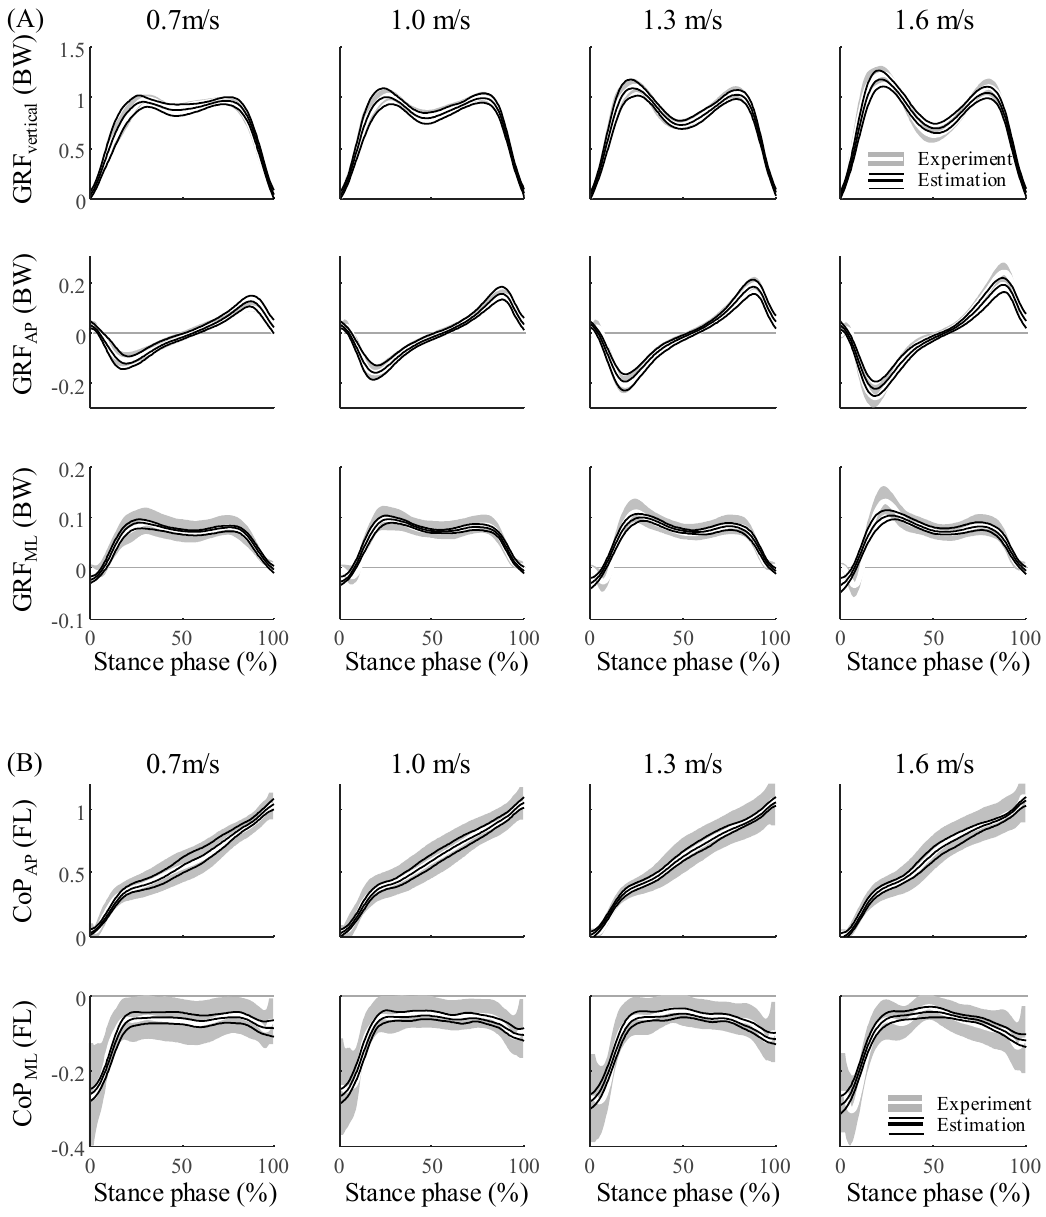
Figure 6. Estimation results and experimental data for ( A ) the GRF and ( B ) the CoP during the stance phase for all 17 participants. The averages and the standard deviations of the estimation results are represented by black thick solid lines and black thin solid lines, respectively, and the averages and standard deviations of the experimental data are represented by a white thick solid line and gray shaded area, respectively.